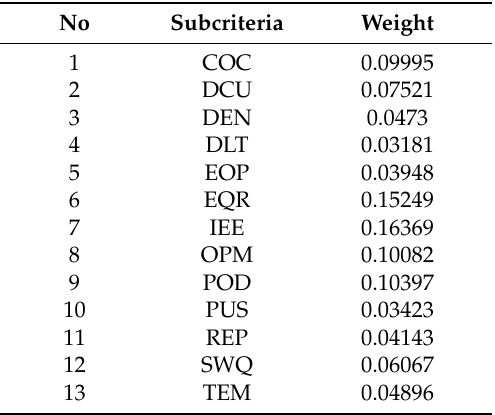
Table 9. The weight of 13 subcriteria.